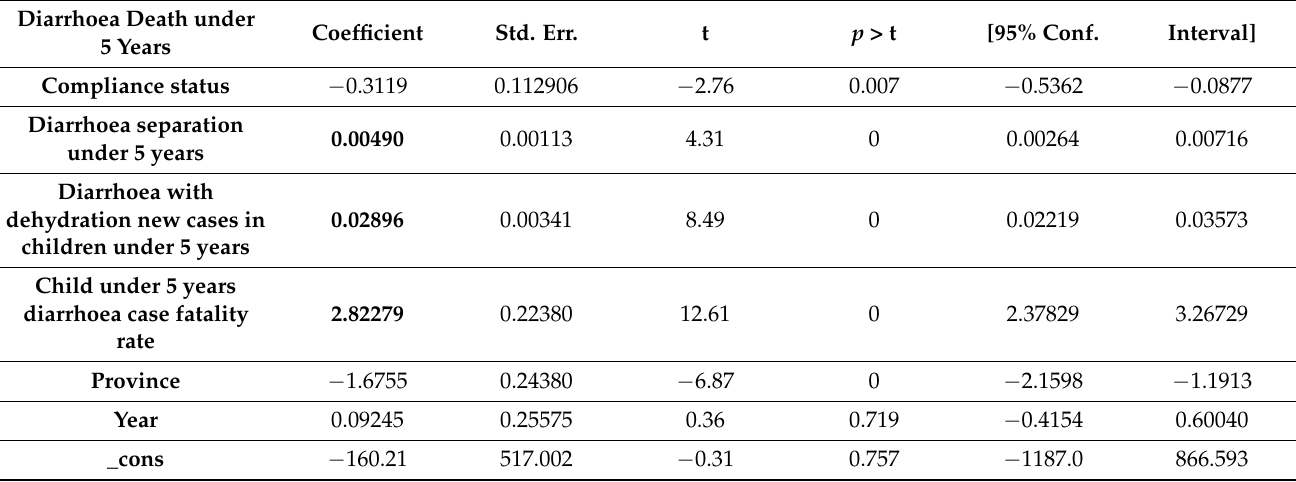
Table 4. Multivariate regression: occurrence of microbial pathogens in water and under 5 years mortality